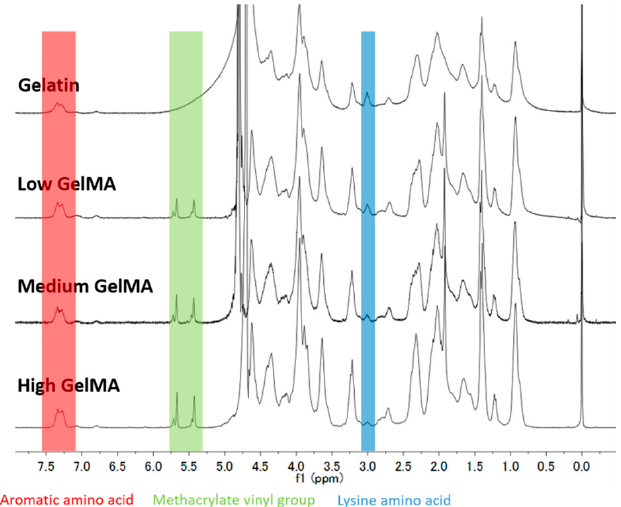
Figure 1. 1 H NMR spectra of unmodified gelatin (Gel), GelMA macromers with different DoF (Low GelMA, Medium GelMA, and High GelMA). Table 1. The DoF of Low GelMA, Medium GelMA, and High GelMA.